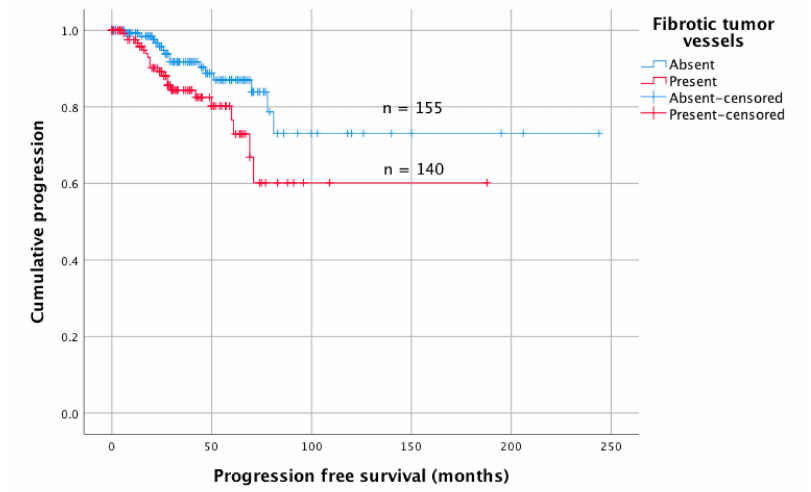
Figure 2. Kaplan–Meier showing correlations between fibrotic tumor vessels and prognosis. Progression-free survival was significantly shorter ( p = 0.029, Log-rank test) in patients when intratumoral fibrotic tumor vessels were present (HR: 2.06, 95%CI 1.02–4.15; p = 0.043). 2.3. Expression of Angiogenesis Related Proteins Correlates with Vessel Fibrosis and Vessel Density Expression of angiogenesis related proteins was compared in tissue lysates of samples from patients with FTV ( n = 8, FTV group) and without FTV ( n = 7, non-FTV, control group) using angiogenesis proteome profiler arrays. Tumors were histologically classified as transitional ( n = 5) and meningothelial meningiomas ( n = 10). Expression of various angiogenesis-related proteins distinctly di ff ered between both groups (Figure 3A,B). In detail, samples from the FTV group showed upregulation of VEGF (4.5-fold), PlGF (2.3-fold), and IGFBP-3 (1.5-fold). In contrast, angiopoetin-1 (3.3-fold), MMP-9 (matrix metalloproteinase-9; 2.1-fold), HB-EGF (heparin-binding endothelial growth factor-like growth factor; 1.9-fold), MMP-8 (matrix metalloproteinase-8; 1.8-fold), IGFBP-1 (insulin-like growth factor-binding protein-1; 1.8-fold), CXCL-16 (chemokine C-X-C motif ligand 16; 1.7-fold), FGF-1 (fibroblast growth factor-1; 1.6-fold), PTX3 (Pentraxin-3; 1.4-fold), TIMP-1 (tissue inhibitor of metalloproteinases-1; 1.3-fold), and thrombospondin-1 (1.3-fold) displayed lower expression in the FTV group as compared to the non-FTV (control)